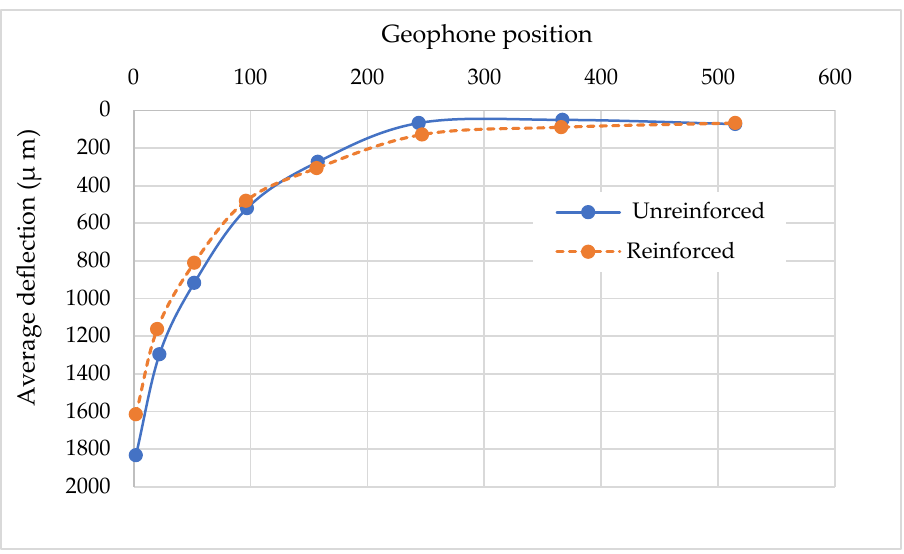
Figure 13. Average of FWD deflection basins layout.